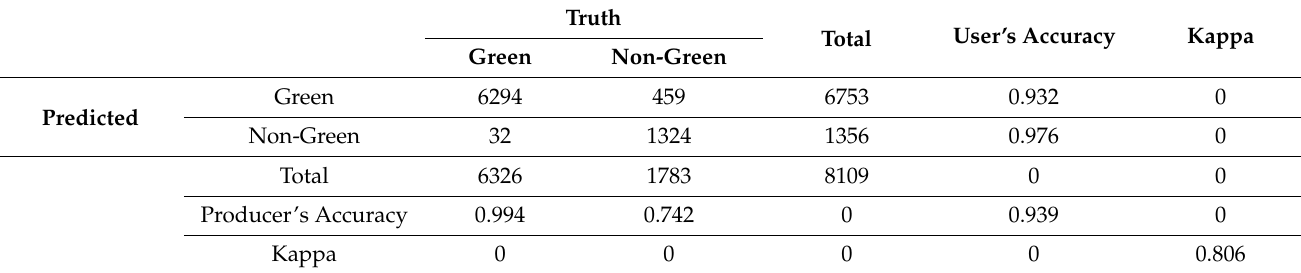
Table 4. Confusion matrix and accuracy assessment of green/non-green classification based on CGLS-LC100,